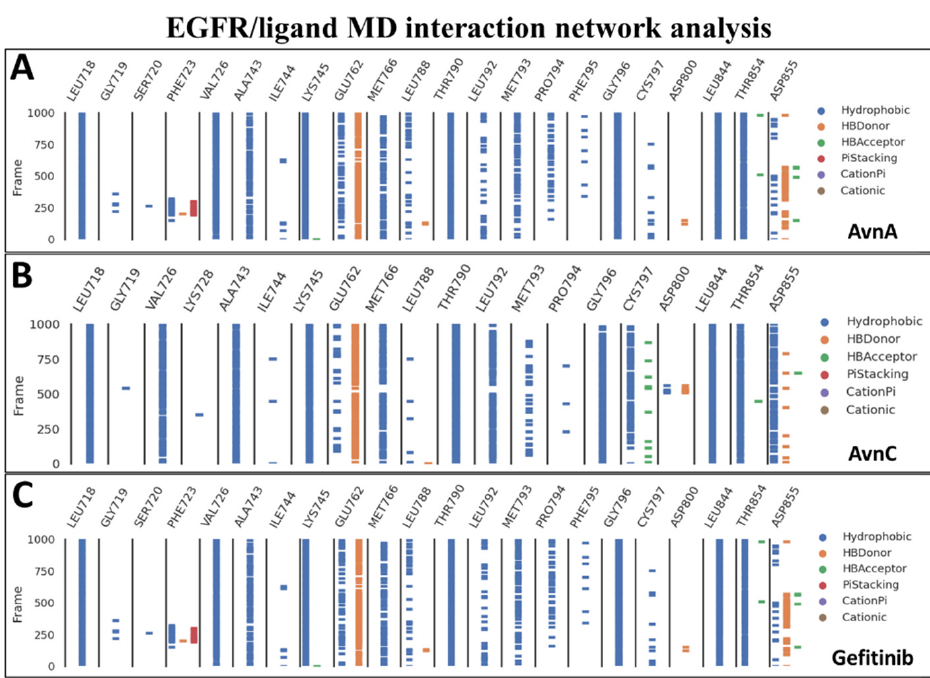
Figure 11. MD interaction network analysis. The binding residues and the molecular dynamics run time (10,000 frames of 100 ns of MD run time) are reported on the x and y axis, respectively. The hydrophobic, π -stacking, cationic, π -cationic interactions, and the hydrogen bonds (HB-Donor and HB-Acceptor) are reported as blue, red, brown, purple, orange, and green lines, respectively for ( A ) AvnA, ( B ) AvnC, and ( C ) gefitinib.